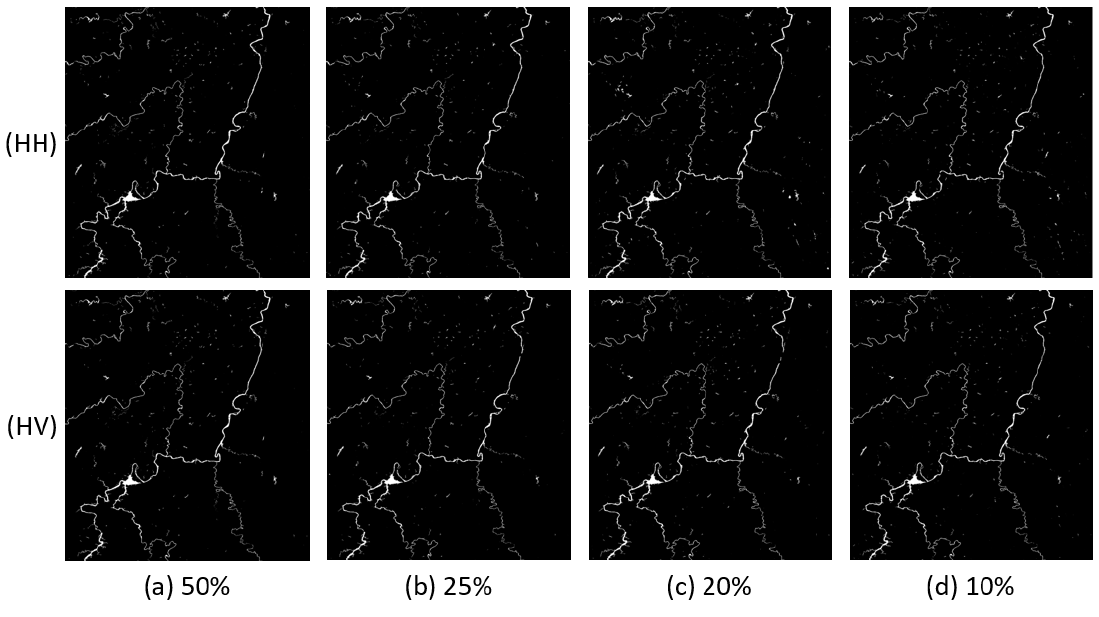
Figure 8. Results comparison of Scene 1 with different p: ( a ) p = 50%; ( b ) p = 25%; ( c ) p = 20%; and ( d ) p = 10%.